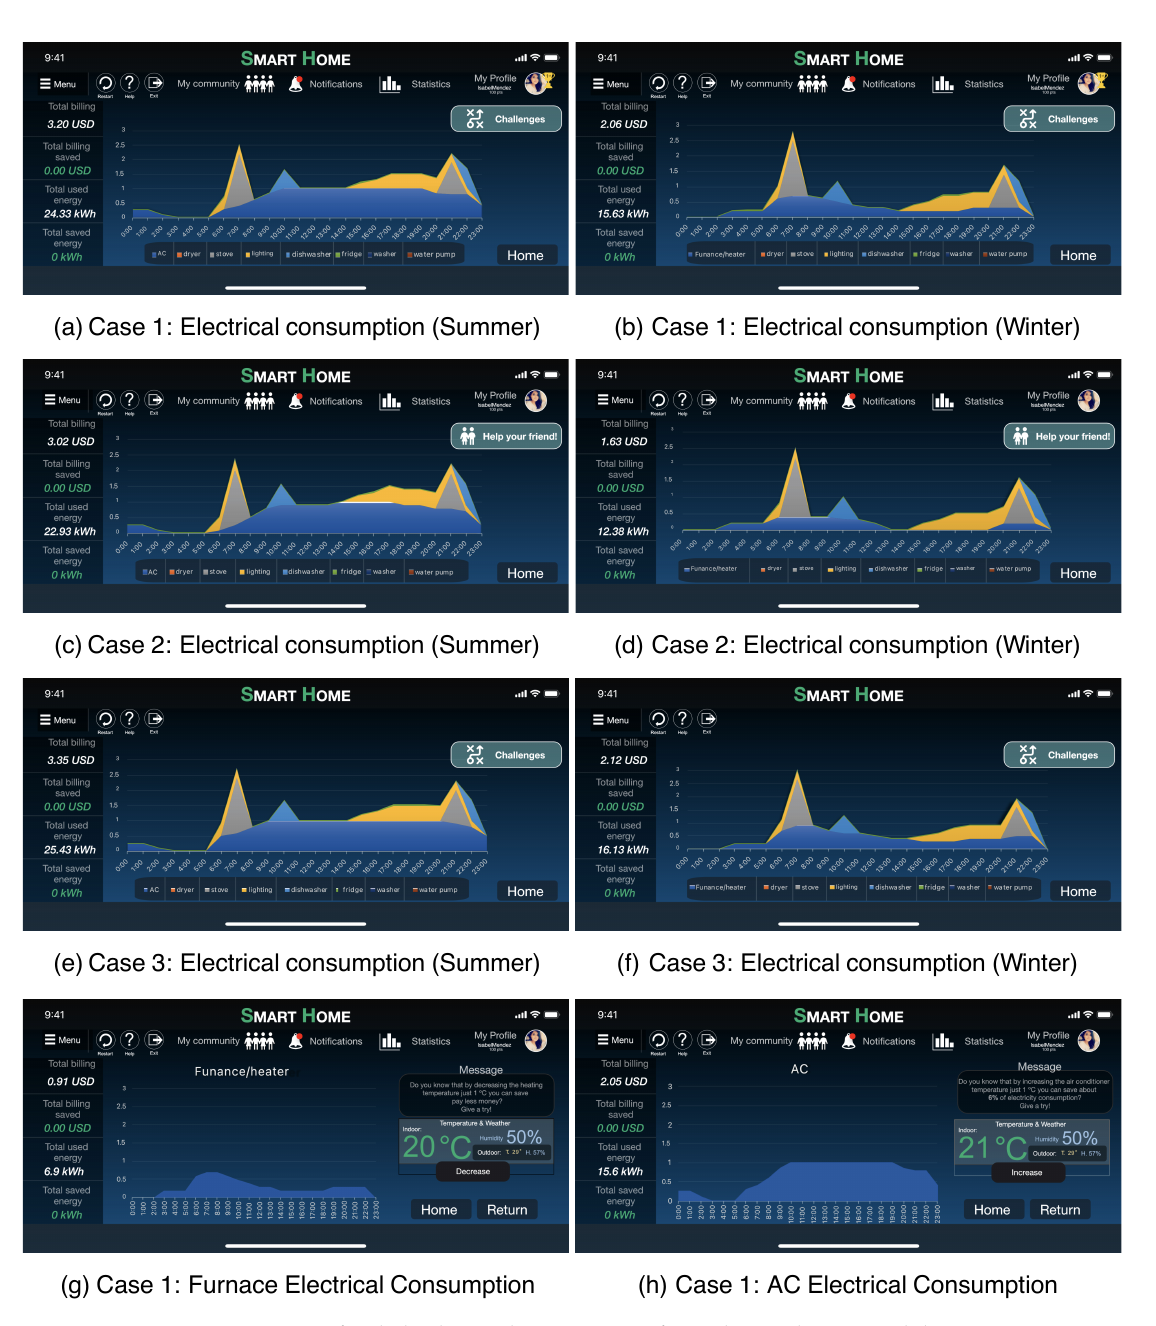
Figure 16. HMI for daily electrical consumption for each case during